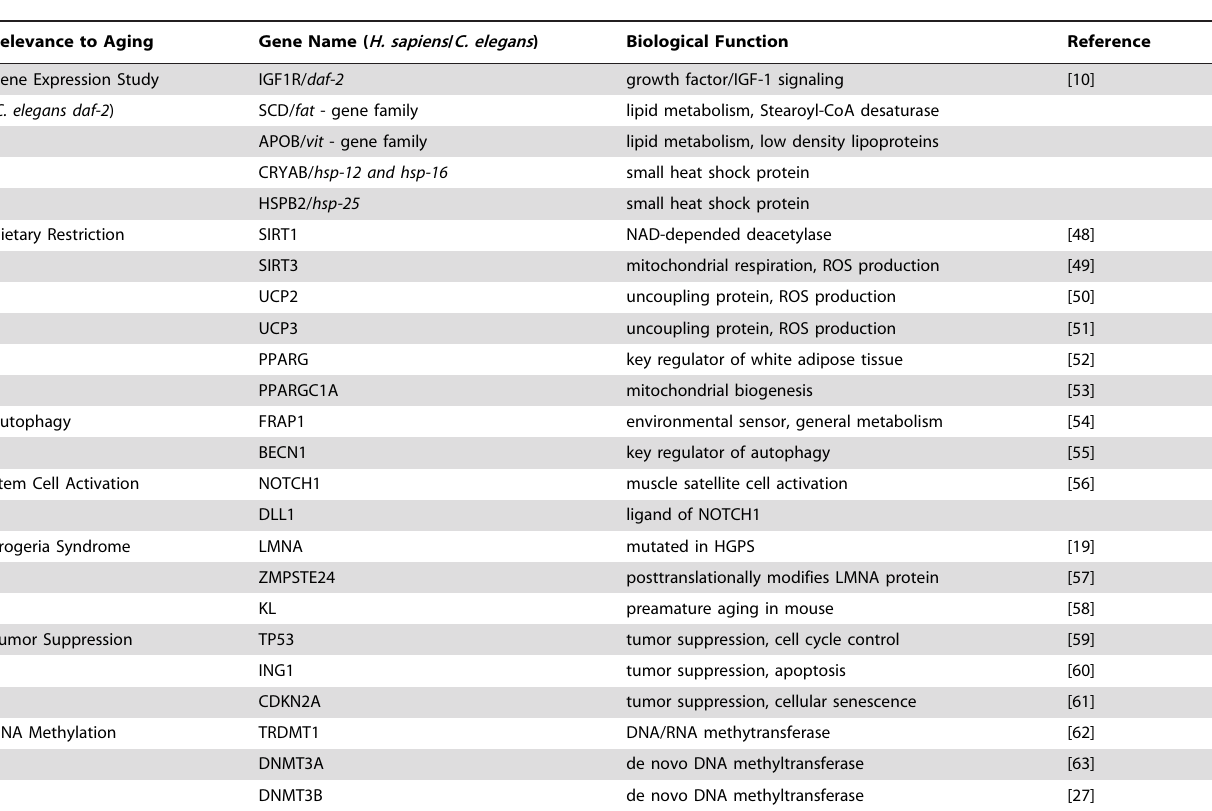
Table 1. Candidate genes, relevance to aging and biological function.